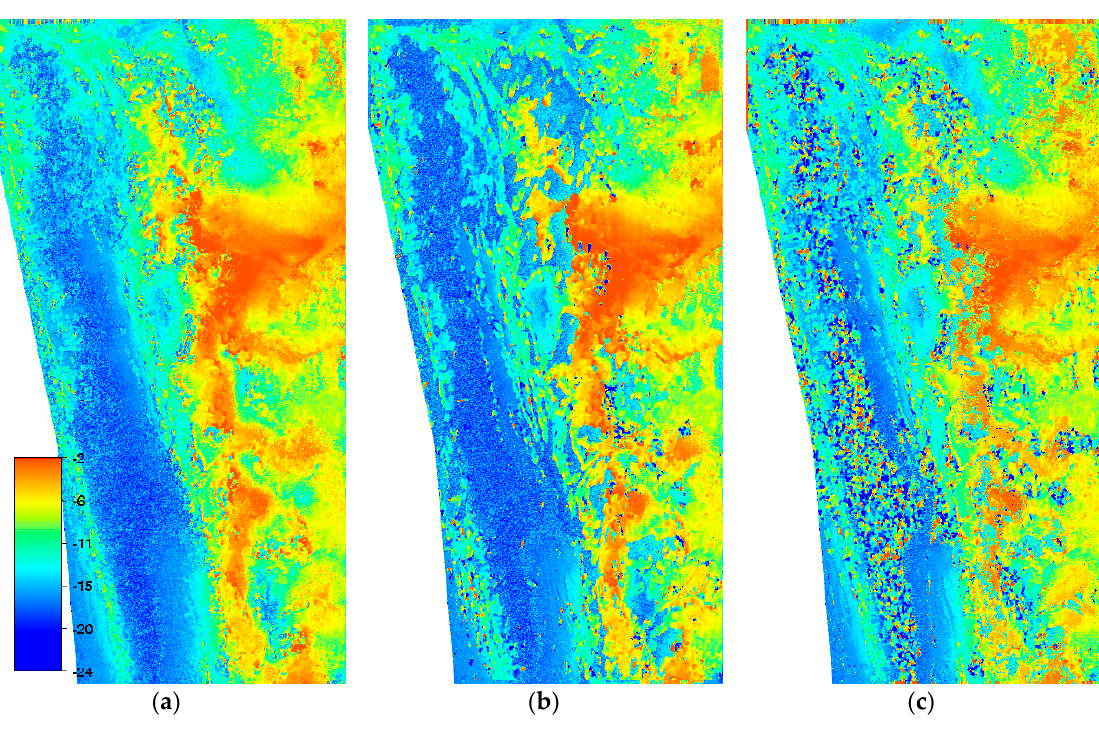
Figure 11. ( a ) The hybrid image based on choosing the better of the two methods for each pixel. ( b ) The hybrid image based on thresholding the standard deviation of the matching window. ( c ) The hybrid image based on the substrate